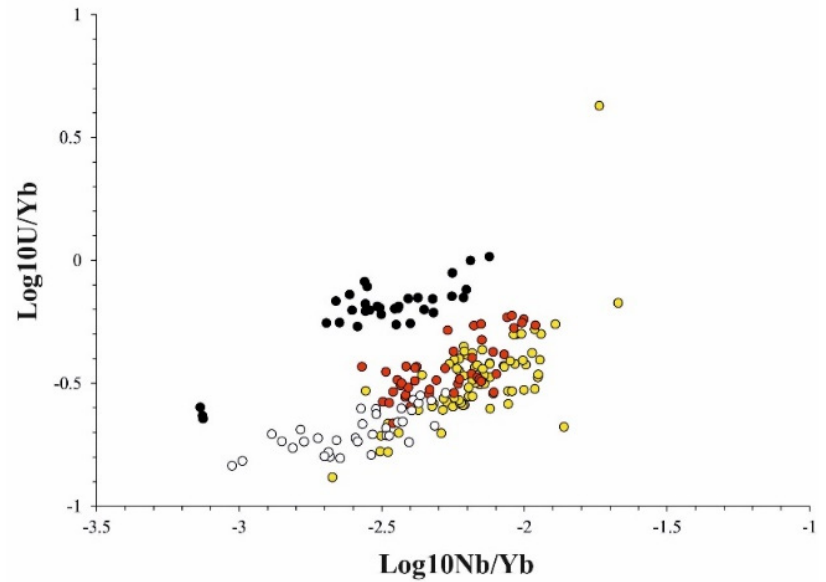
Figure 8. ( A ) U/Yb vs. Hf and ( B ) U/Yb vs. Y diagrams according to [57]. Symbols as in Figure 7.